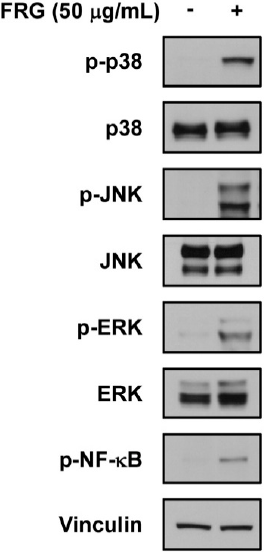
Figure 5. Involvement of p38, ERK, JNK, and NF- κ B in the immunomodulatory effect of FRG. RAW264.7 cells were treated with FRG for 0.5 h. Cells were lysed, and proteins were subjected to immunoblotting. Vinculin was used as a loading control.